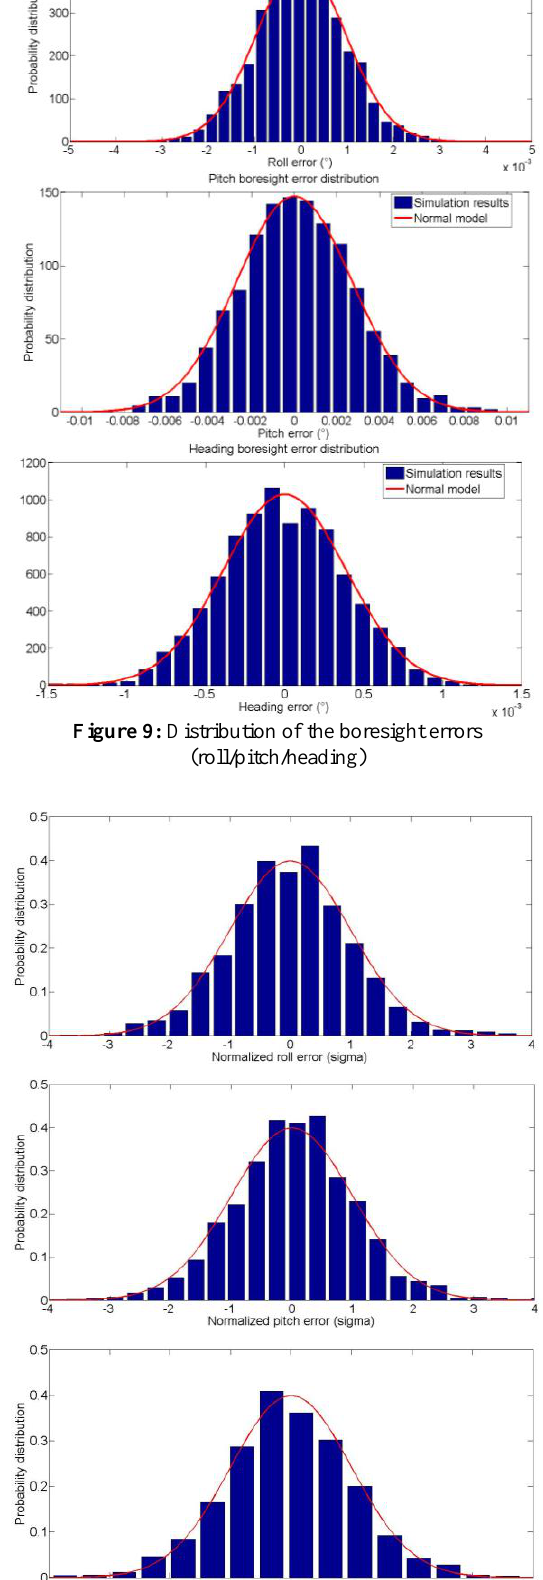
Figure 10: Roll/Pitch/Heading normalized